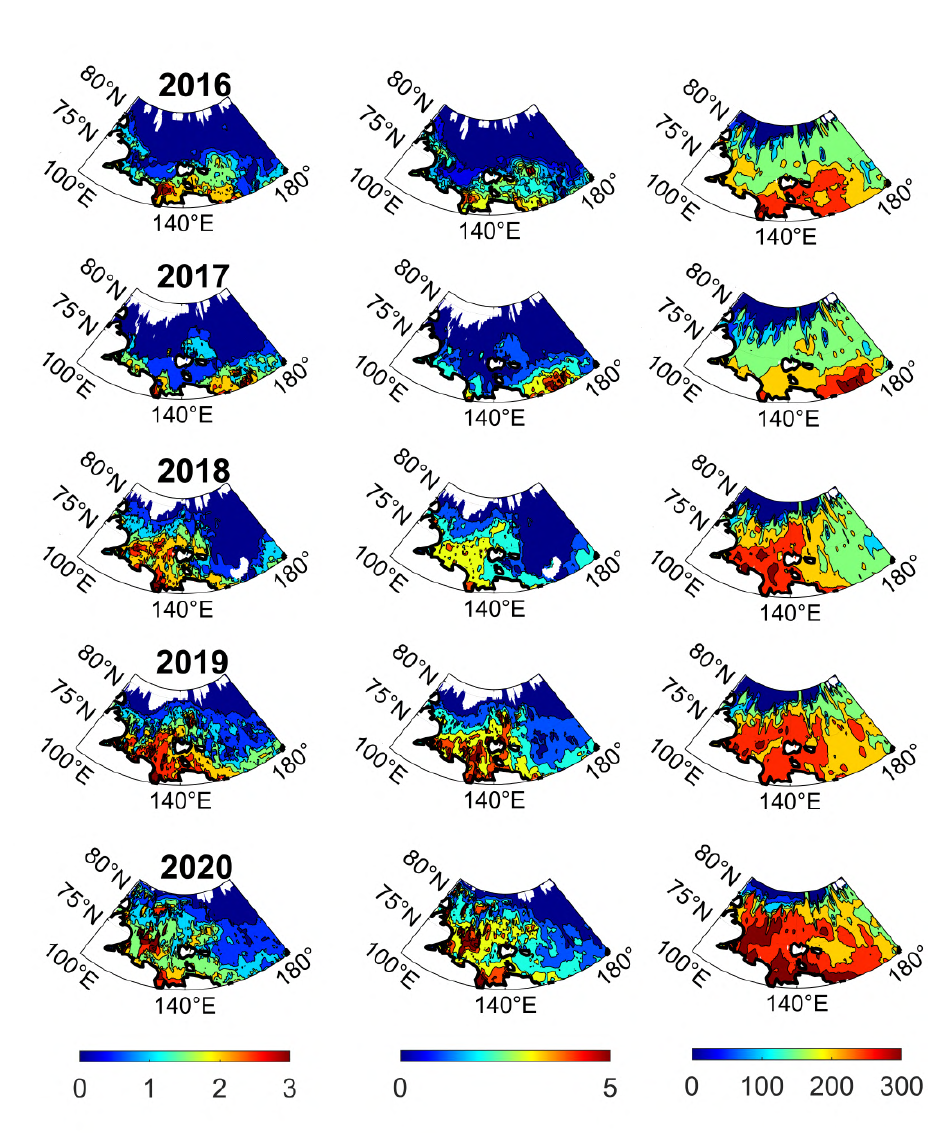
Figure 4. MHWs in the Laptev and East Siberian seas in 2016–2020. Left column shows annual mean intensity (in ◦ C), central column—annual maximum intensity (in ◦ C), right column—total duration (in days) of the MHW during the